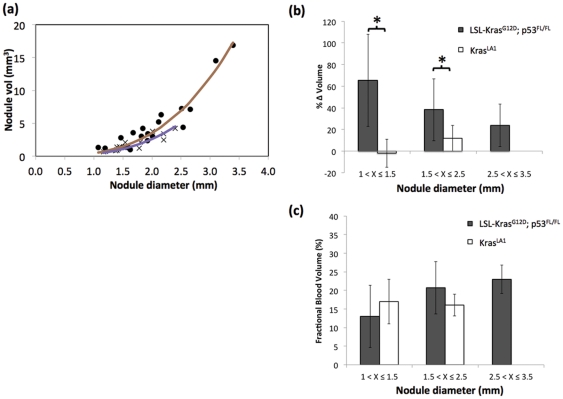
Correlation between nodule volume and diameter in LSL-KrasG12D;p53FL/FL (•) and KrasLA1 (×) models.(a). Solid lines indicate cubic fit to the data points. An R2 value of 0.93 and 0.81 was obtained for LSL-KrasG12D;p53FL/FL and KrasLA1 models, respectively. Percentage change in nodule volume in the two lung cancer models as a function of nodule diameter (* indicates p<0.05) (b). CT-derived fractional blood volume as a function of nodule diameter (c).